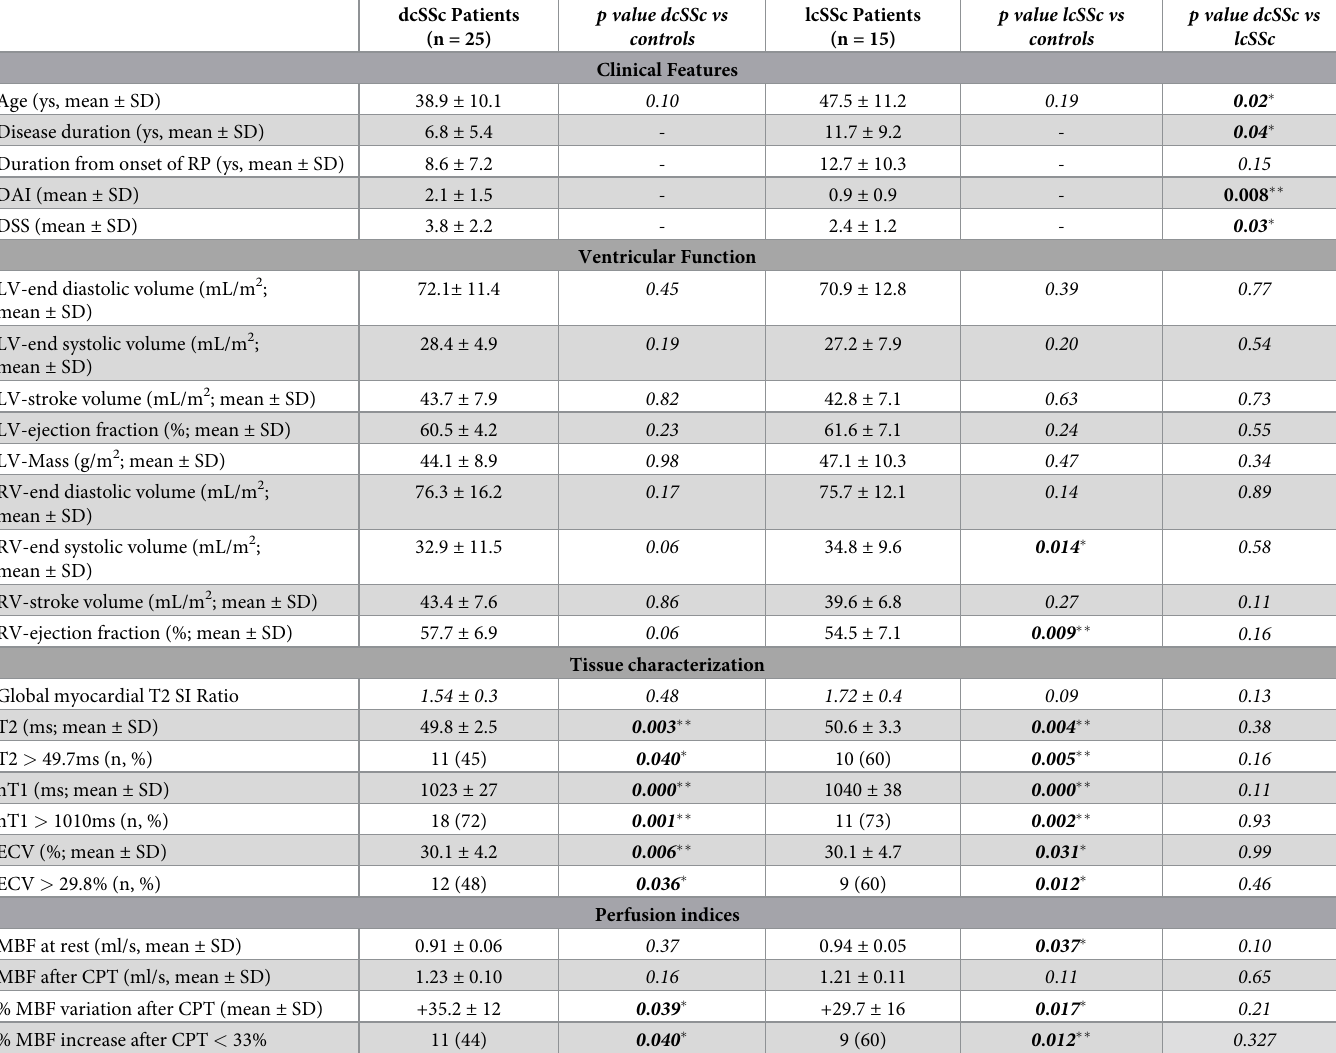
Table 3. Clinical characteristics and CMR features of dcSSc and lcSSc patient subgroups and paired comparison.